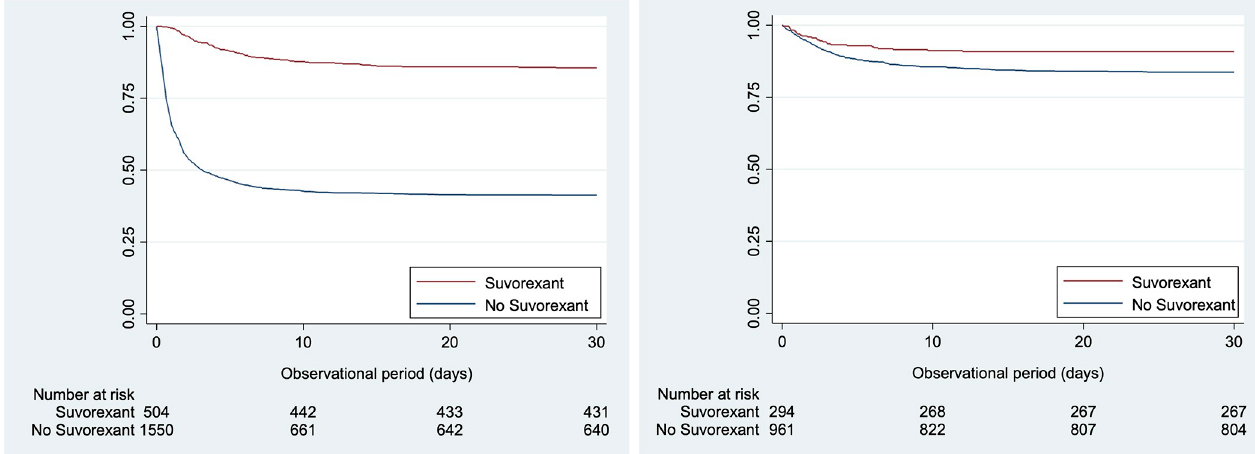
Fig 3. Kaplan-Meier survival analysis. a. Kaplan-Meier survival analysis of the “any time before” analysis. b. Kaplan-Meier survival analysis of the “within 72h” analysis.